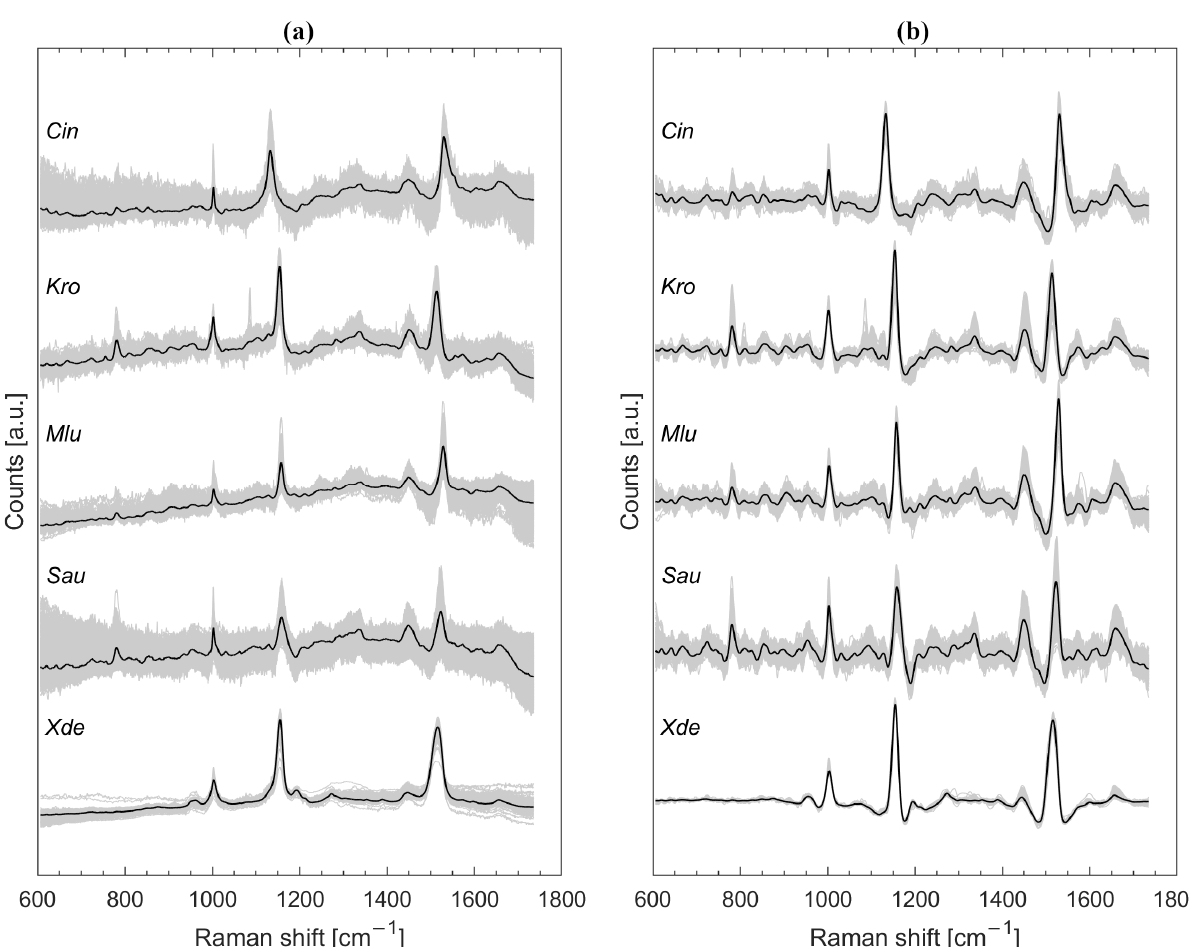
Figure 2. All Raman spectra of the carotenoid-containing microorganisms in grey and arithmetic mean spectra highlighted in black (displayed with a Y -axis offset). Untreated-but-normalized Raman spectra ( a ) and preprocessed spectra (baseline subtraction, smoothing, z-score normalization) ( b ).